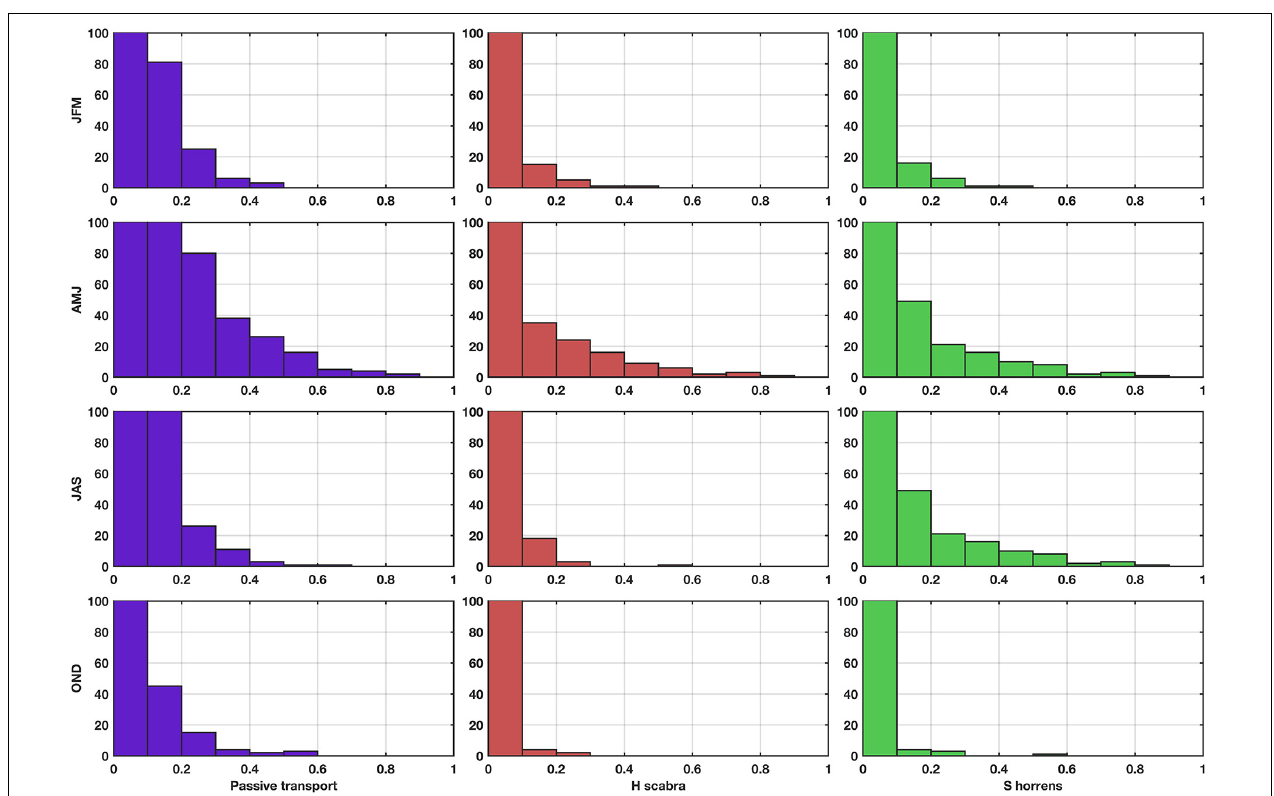
FIGURE 5 | Histogram of settlement probabilities per season (rows from top to bottom: NEM, dry-transition, SWM and early NEM) under passive transport ( column 1 , purple-shaded bars), H. scabra ( column 2 , red-shaded bars), and S. horrens ( column 3 , green-shaded bars) habitat conditions. Most connections had a probability of less than 0.2, and for passive transport conditions approximately 1,000 connections had probabilities equal to or less than 0.1. The maximum number of connections plotted was capped at 100 to emphasize changes in the number of connections with probabilities greater than 0.2 for H. scabra and S. horrens .